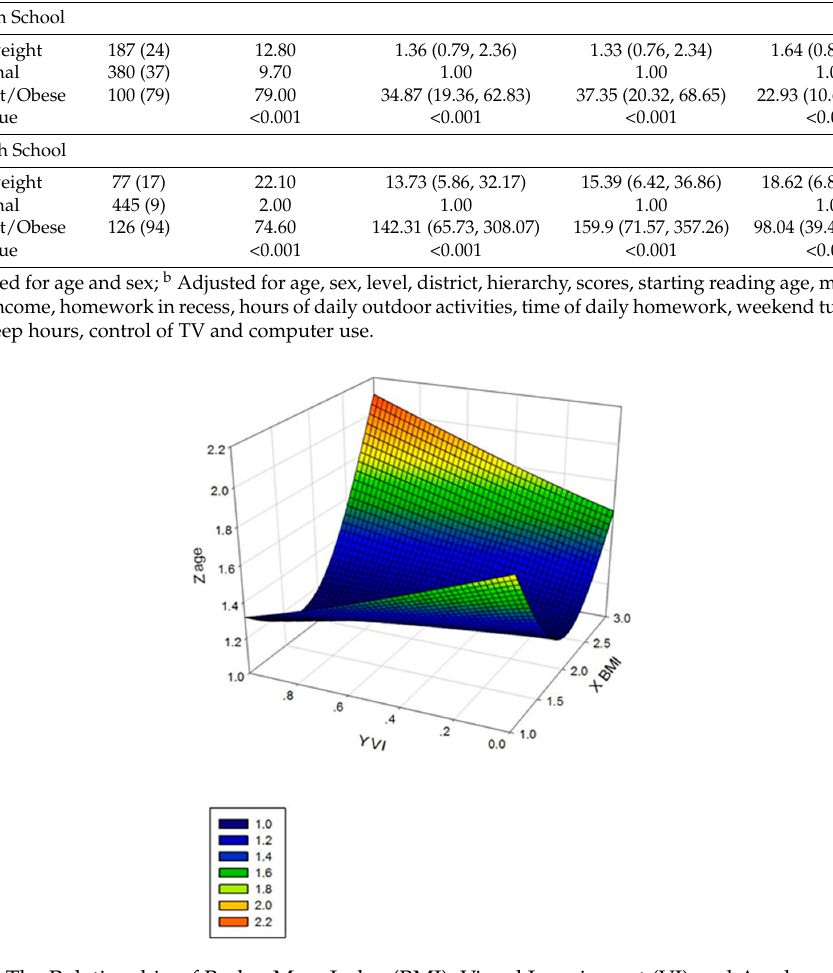
Figure 1. The Relationship of Boday Mass Index (BMI), Visual Impairment (VI) and Age based on the 3D Image. Age was divided into three grades according to the primary school (6–13 years), junior high school (14–16 years) and senior high school ( ≥ 17 years). BMI was categorized into underweight, normal, overweight/obese.